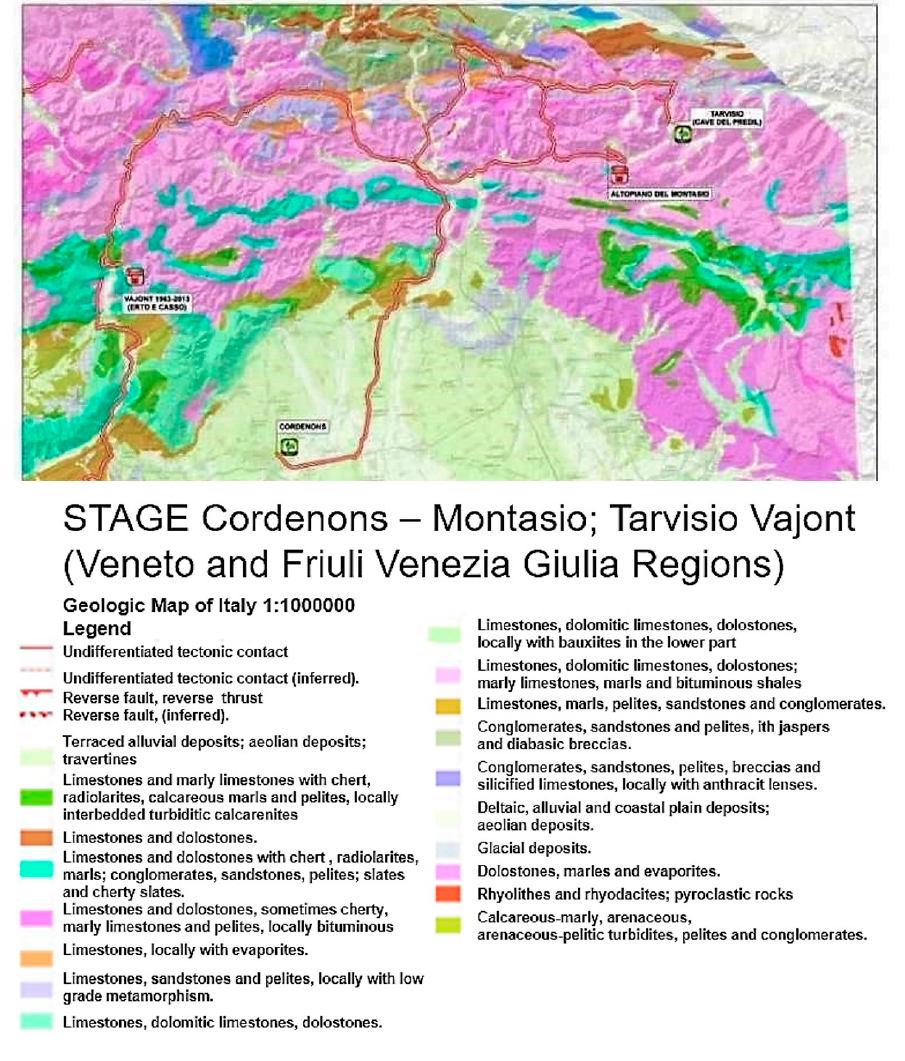
Figure 1. Stages crossing Veneto and Friuli Venezia Giulia Regions (NE of Italy), where the case study is located, represented on the Geologic Map of Italy at the synthetic scale 1:1,000,000. The Vajont site commemorated the landslide tragic event, 50 years later.